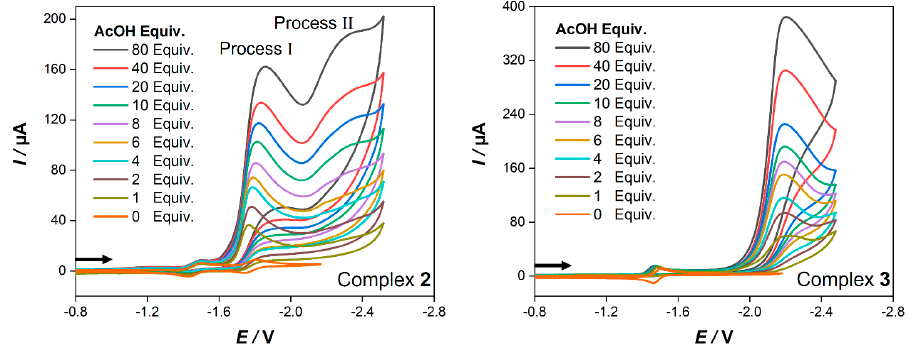
Figure 6. Cyclic voltammetry (0.2 V/s) of 1.0 mM of complexes 2 (left) and 3 (right) in CH 2 Cl 2 − [ n − Bu 4 N][BF 4 ] (0.1 M) in the presence of different equivalents of AcOH. Potential E is